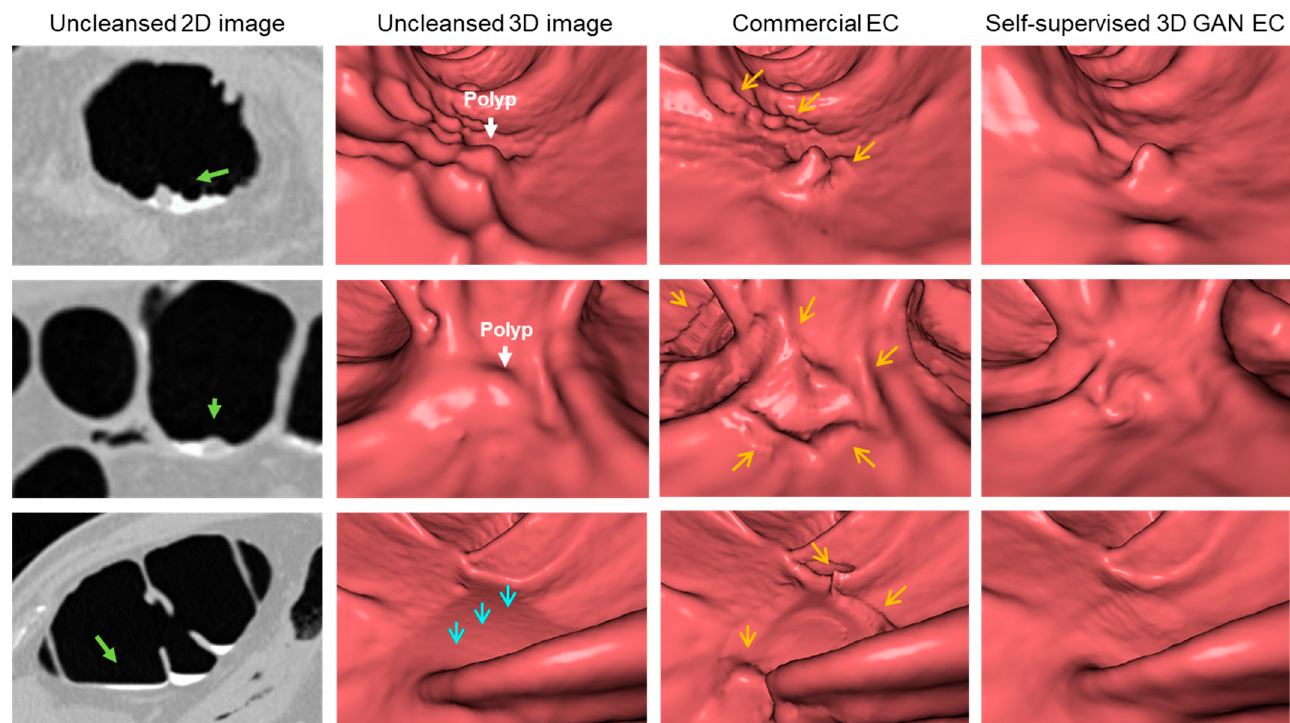
Figure 5. Visual comparison of the virtual cleansing by the self-supervised 3D-GAN EC and commercial EC. In the first column, the green arrows show the direction of the virtual camera in the virtual 3D fly-through views to the right. In the second column, the white arrows on the top and middle rows show locations of polyps partially submerged in residual feces, and on the bottom row, the cyan arrows indicate the location of a thin layer of fluid to be cleansed. In the third column, the orange arrows indicate locations of observed EC image artifacts by the commercial EC, which are not present on the EC images of the self-supervised 3D-GAN EC in the fourth column.